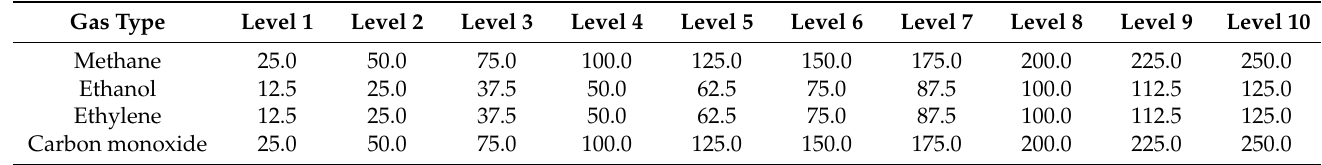
Table 2. Different concentration levels of measured gases (ppm).